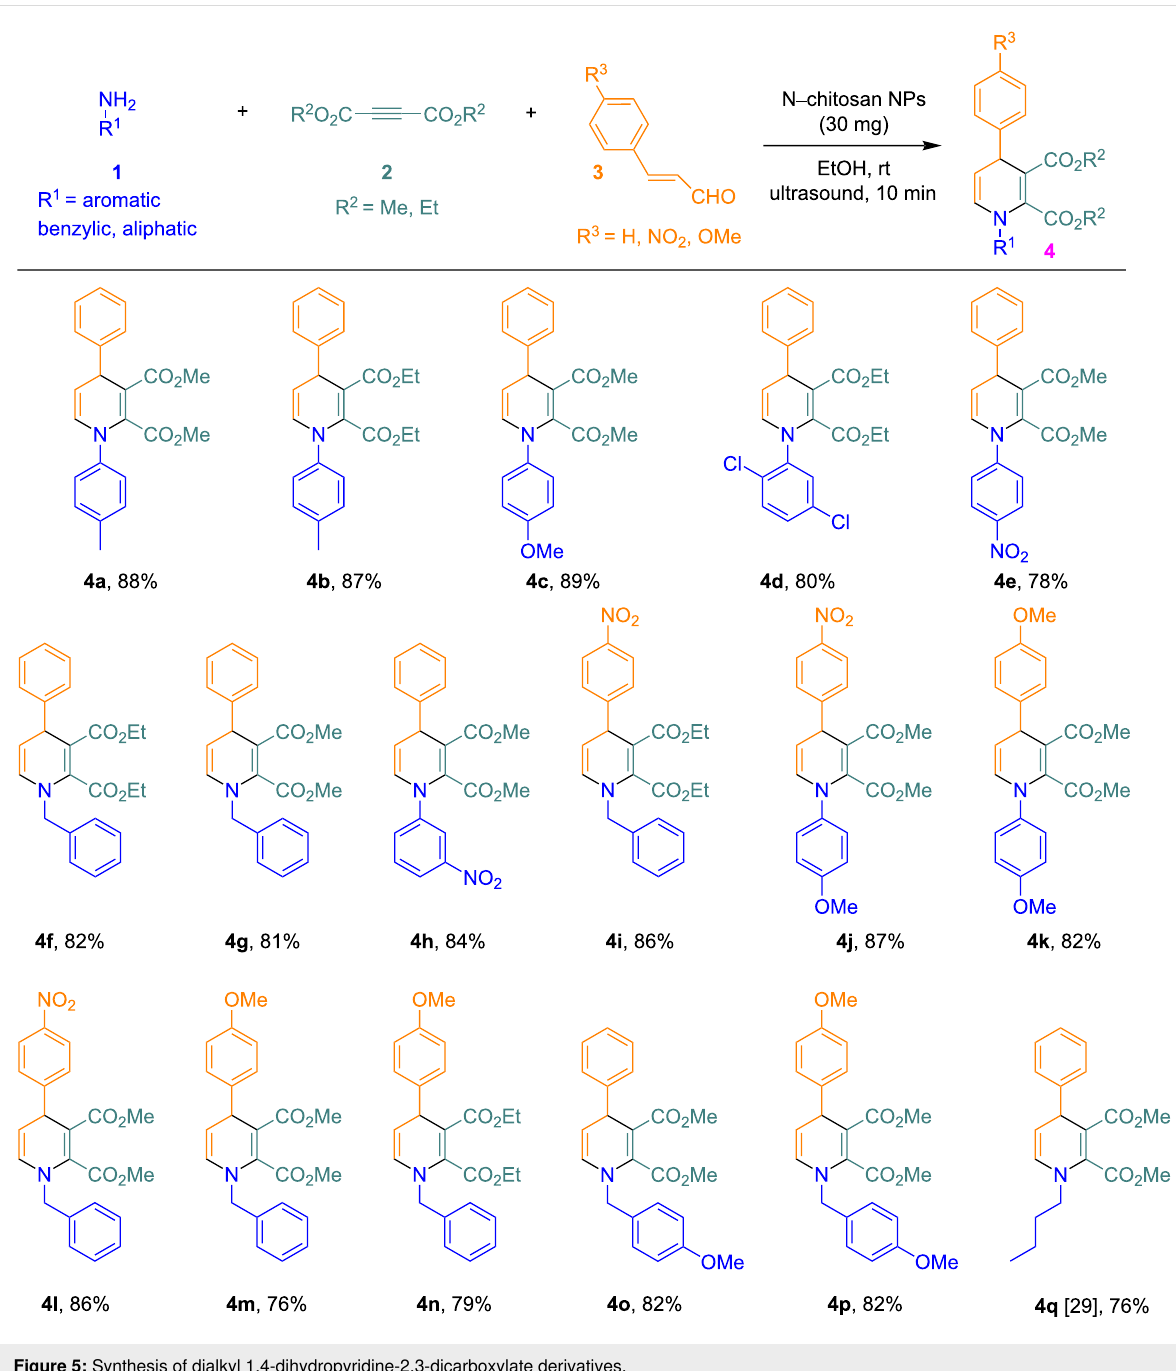
Figure 5: Synthesis of dialkyl 1,4-dihydropyridine-2,3-dicarboxylate